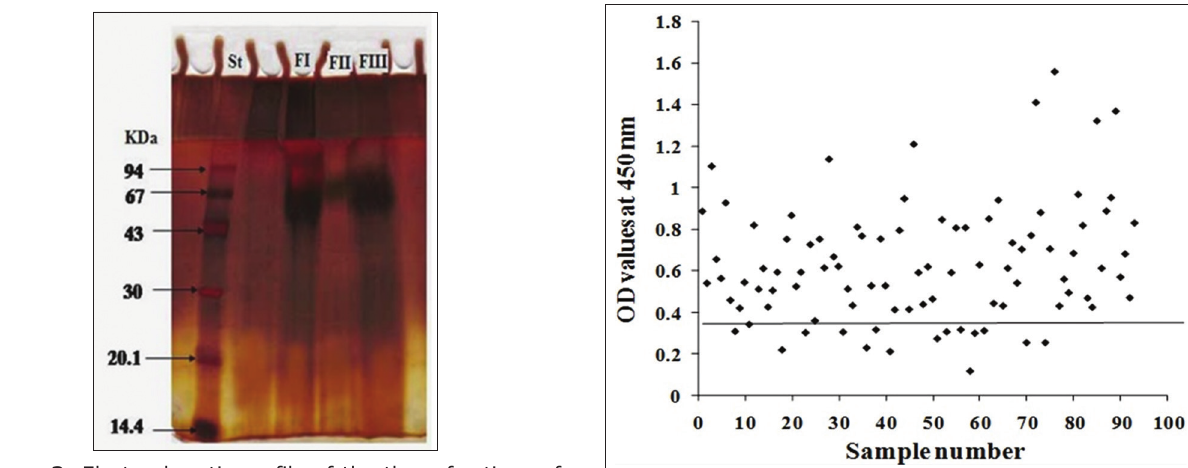
Figure-2: Electrophoretic profile of the three fractions of camel HCF antigen FI, FII, FIII, and Low Molecular weight standards (lane St).